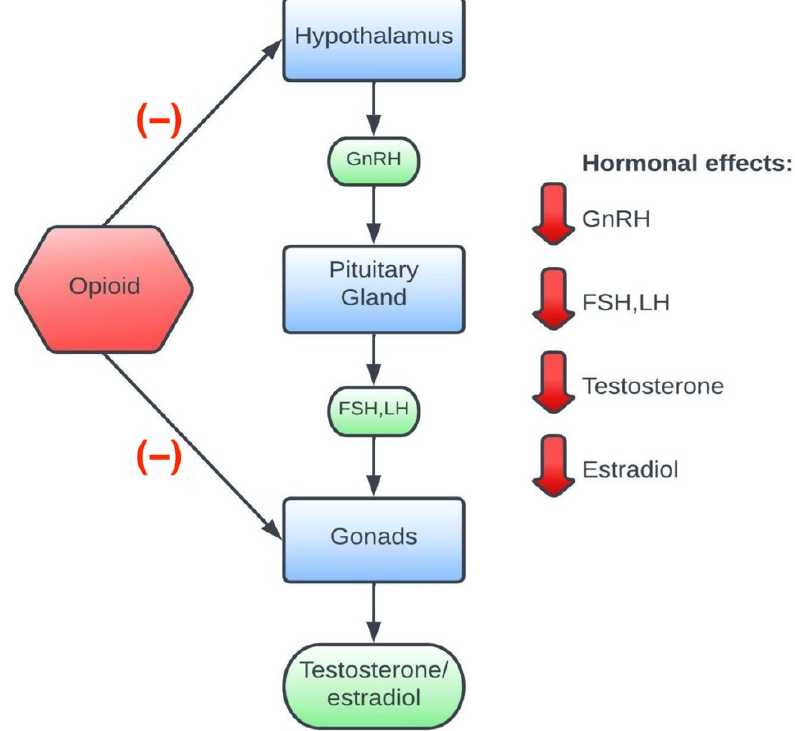
Figure 1. The impact of opioids on the hypothalamus − pituitary − gonadal axis.